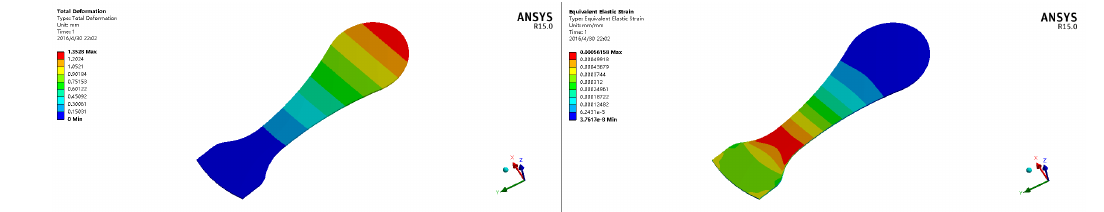
Figure 3. Deformation and strain of the reed valve.